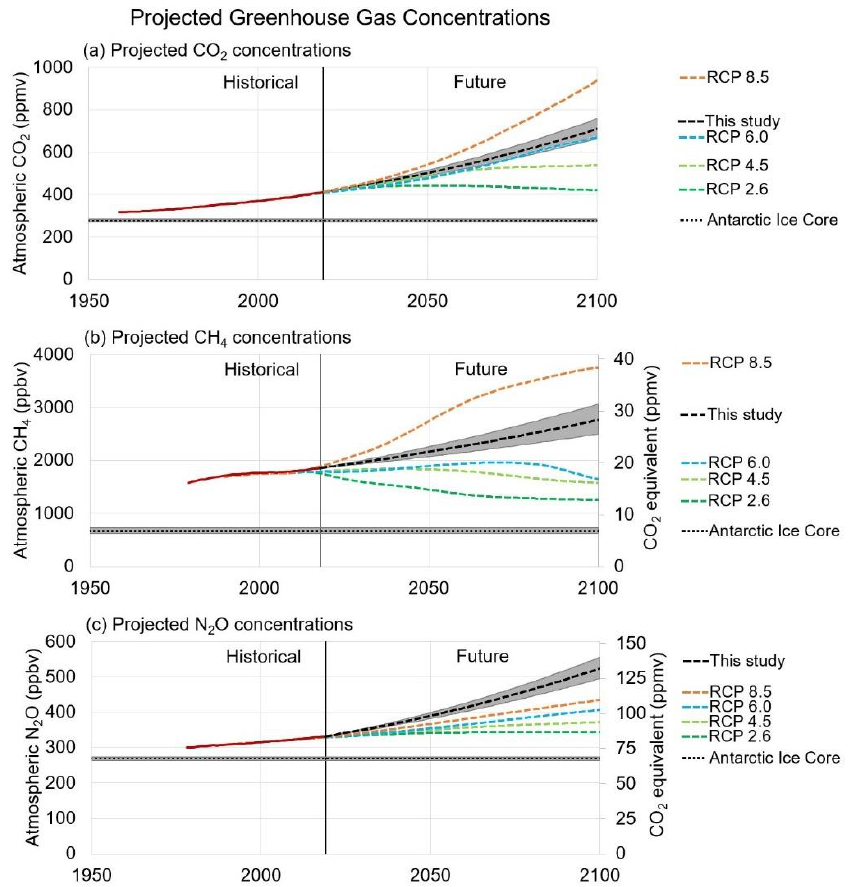
Figure 10. Future greenhouse gas concentrations up to 2100 under "Business-As-Usual" conditions, compared to the RCP scenarios, for ( a ) CO 2 ; ( b ) CH 4 ; and ( c ) N 2 O. Concentrations for CH 4 and N 2 O in “CO 2 equivalents” are shown on the right-hand side vertical axes for comparison. The horizontal axes correspond to years.